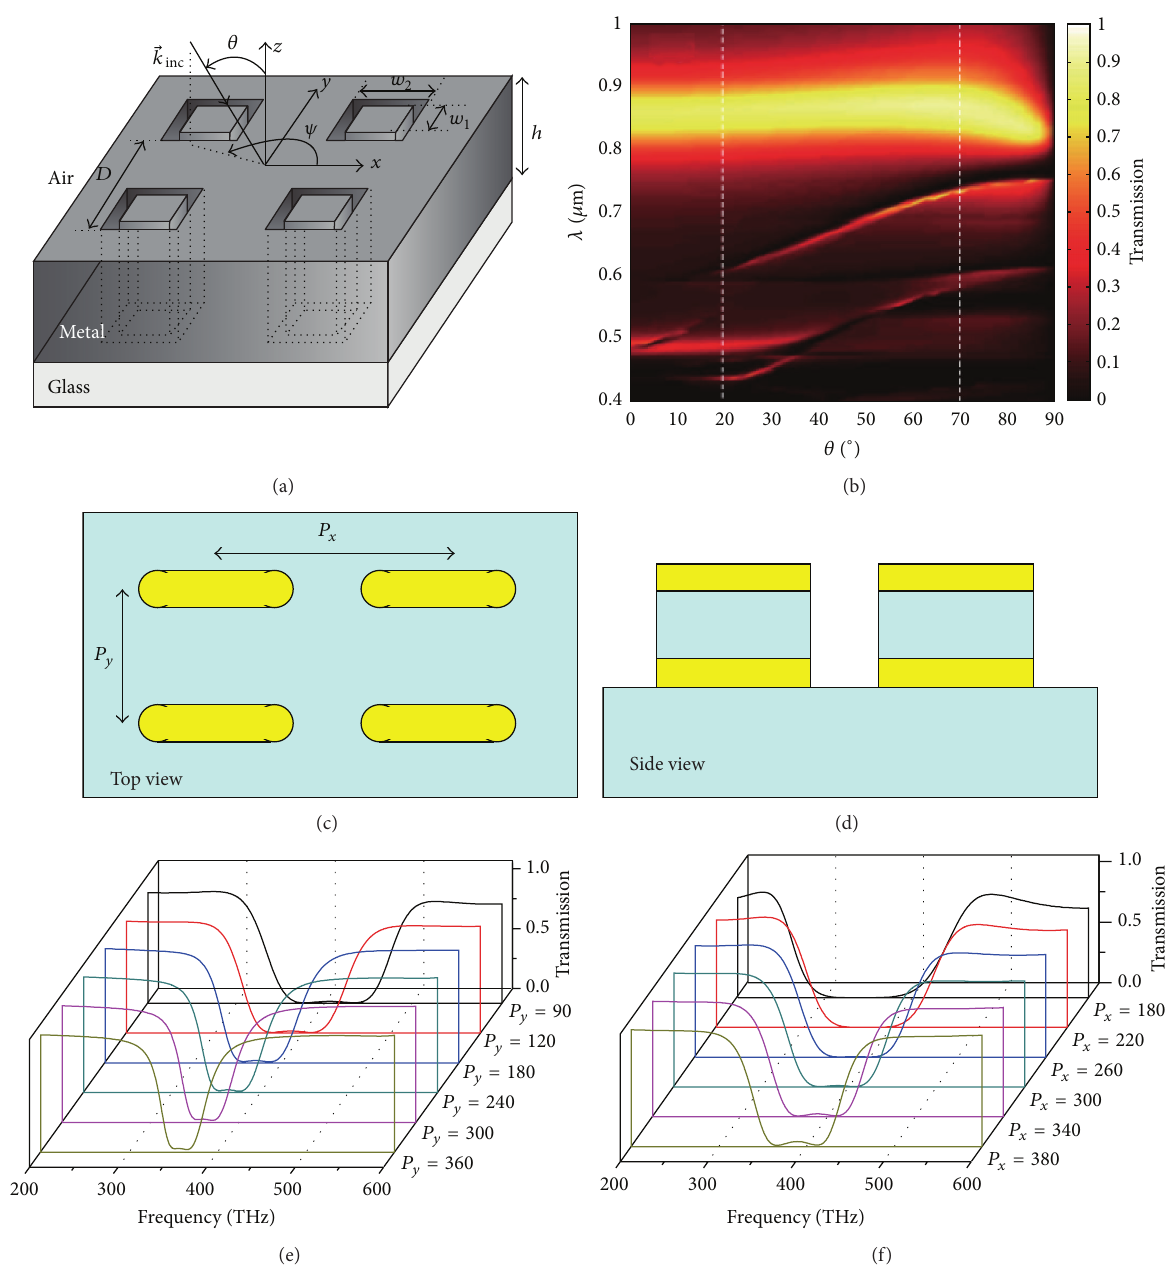
Figure 4: (a) Sketch of the large-angle FSS. (b) Evolution of the transmission efficiency as a function of the angle of incidence and incident wavelength. (c, d) Top and side views for the tunable band-stop FSS. (e, f) Evolution of the transmission spectra with different geometric parameters. Figures are reproduced from (a, b) [15] and (c)–(f)